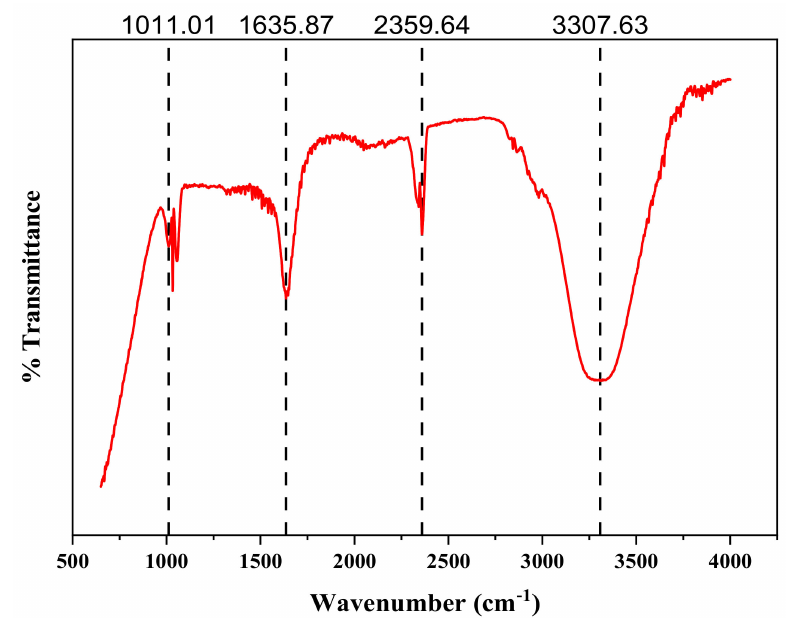
Figure 9. FTIR spectra of synthesized silver nanoparticles.